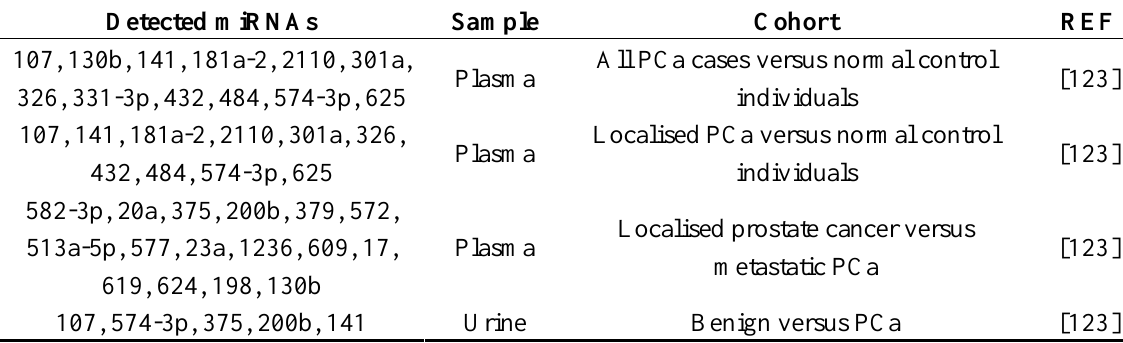
Table 3. Potential miRNA biomarkers associated with circulating vesicles in